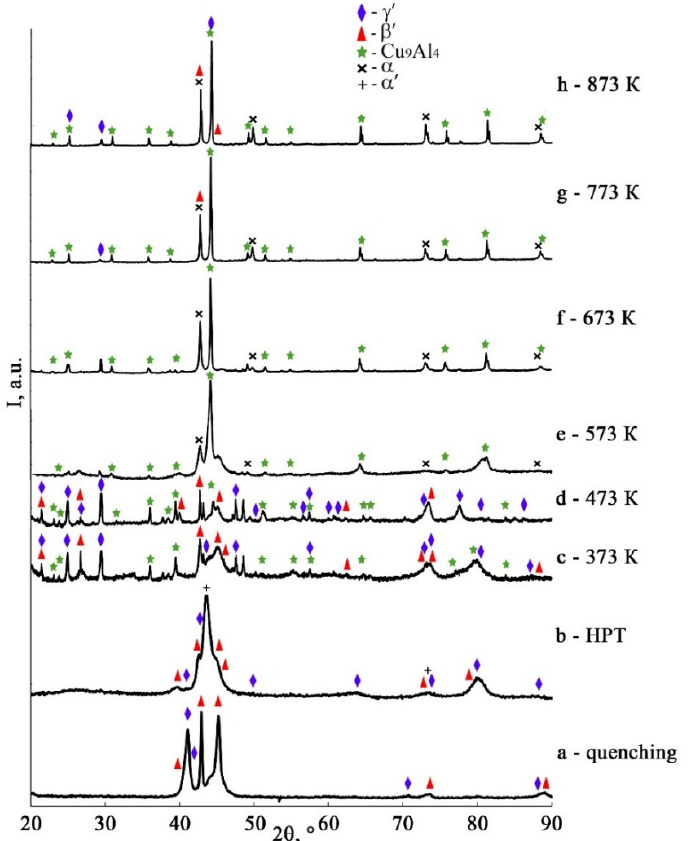
Figure 27. XRD spectra for the alloy Cu–14Al–3Ni after its ( a ) quenching, ( b ) HPT of 10 rev, and ( c – h ) HPT of 10 rev + annealing at 373 K–873 K, 30 min. Temperatures of measurements: ( a ) 200 K, ( b – h ) RT [64].